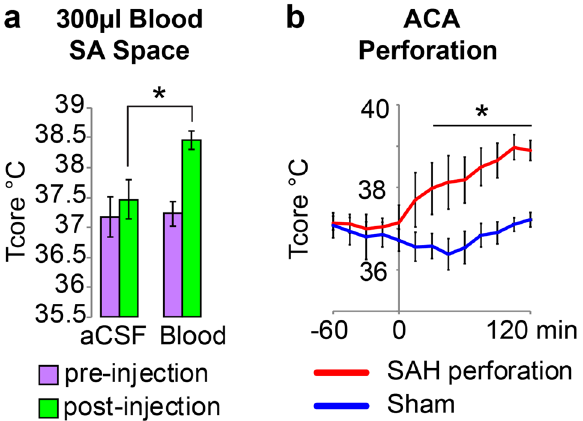
Figure 1. NF is triggered by release of blood into SA space. ( a ) Group data representing the changes body temperature (T CORE ) between baseline (pre-injection) and 120 min following (post-injection) direct injection of blood or artificial cerebrospinal fluid (aCSF), into the subarachnoid (SA) space. The injection of blood, but not aCSF, elicited an increase in T CORE . ( b ) Group data representing the time course of the changes in T CORE following perforation of the anterior cerebral artery (ACA), or the sham perforation procedure. The extravascular release of blood into the SA space, produced by the perforation of the ACA, led to a significant increase in T CORE . *p <